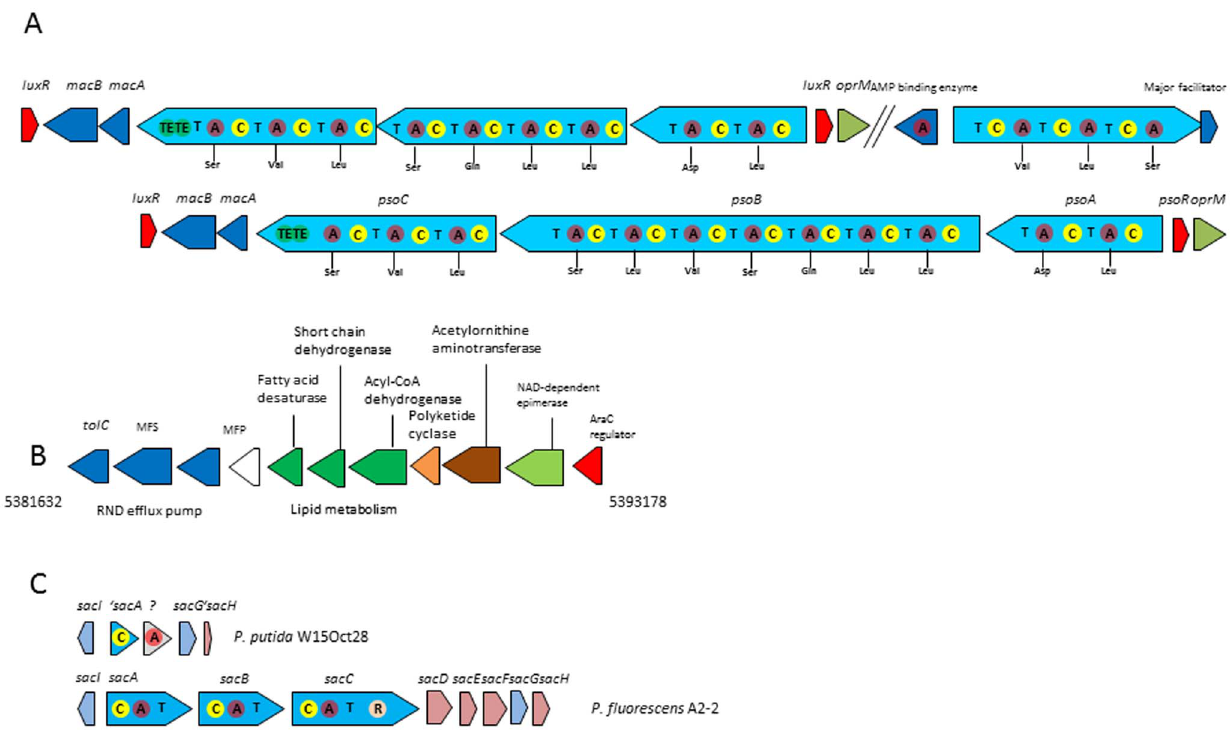
Figure 3. Genes involved in the production of secondary metabolites. A. Genes involved in the production of putisolvins in strain W15Oct28 (top) and strain P. putida PCL1145 (bottom): psoA , psoB , and psoC are the genes encoding NRPS enzymes with their condensation (C), adenylation (A) domains showing the predicted activated amino acid, and the T domain for the thioester attachment of the activated amino acid. The two thioesterase domains responsible for the detachment of the completed peptide at the end of psoC are also indicated (TE). The macA and macB genes correspond to a transporter, the oprM gene coding for an efflux system porin, and the two orphan luxR genes are shown in red. The amino acids predicted to be activated by the different A domains by the antiSMASH analysis are indicated without mentioning whether they are in the D- or L- form. B. The ten genes cluster possibly involved in the biosynthesis of a secondary metabolite. The cluster is preceded by a gene encoding an AraC regulator. See the text for details. C. The incomplete safracin gene cluster of W15Oct28 compared to the complete safracin gene cluster of P. fluorescens A2-2.